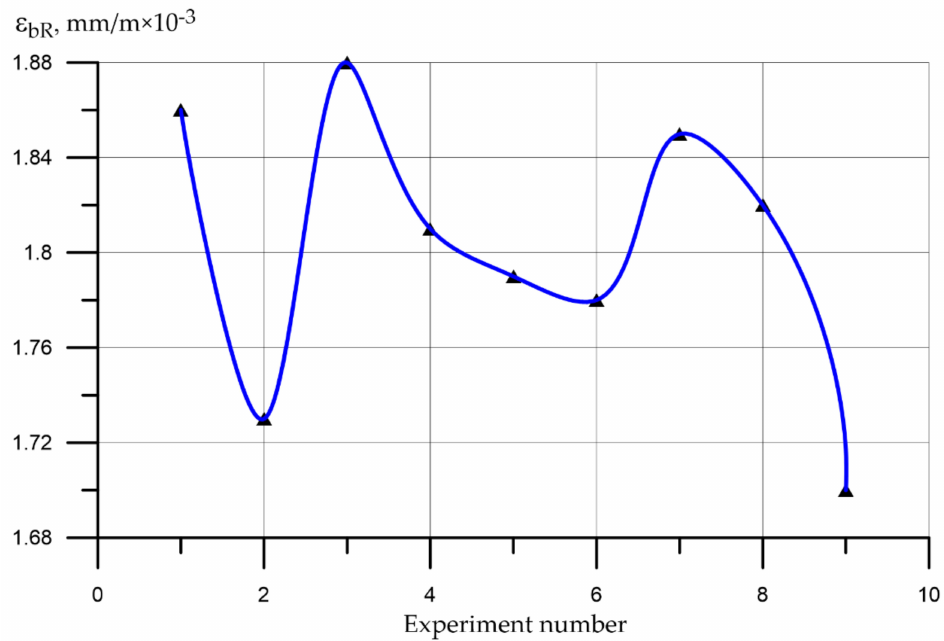
Figure 10. Change in the ultimate deformations during the axial compression of LFRC on a combined aggregate, depending on the volumetric content of fiber-reinforced concrete and the method of its distribution during the preparation of a fiber-reinforced concrete